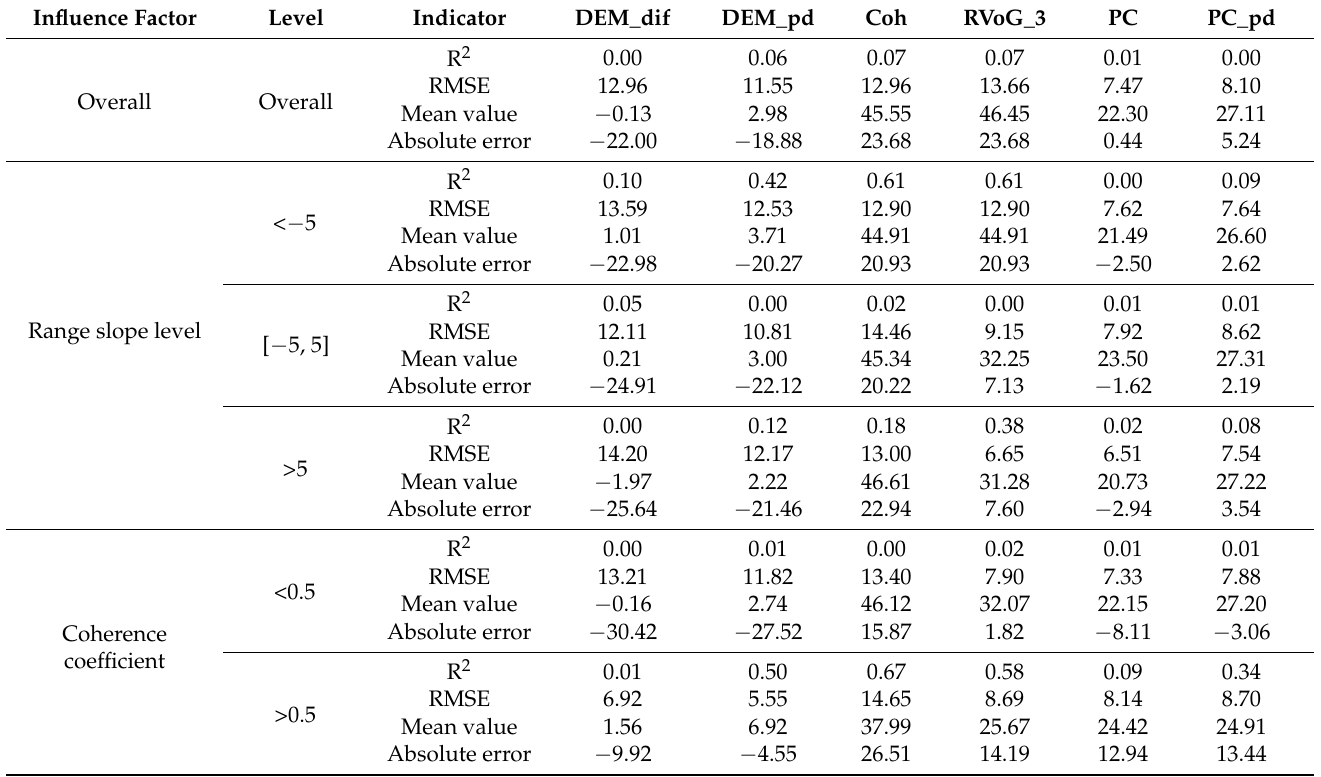
Table 5. The error table of the estimation methods for 73–75 (DEM_dif: the differential DEM algorithm which uses HV and HH-VV polarization to represent the canopy-top phase and the ground phase; DEM_pd: the differential DEM algorithm which uses the PD High and PD Low as the canopy-top and ground phase; Coh: the coherent amplitude algorithm; RVoG_3: the three-stage RVoG estimation algorithm; PC: the coherent phase-amplitude algorithm which uses the HV and HH-VV polarization to represent the canopy-top and the ground phase; PC_pd: the coherent phase-amplitude algorithm which uses the PD High and PD Low to represent the canopy-top and the ground phase). Influence